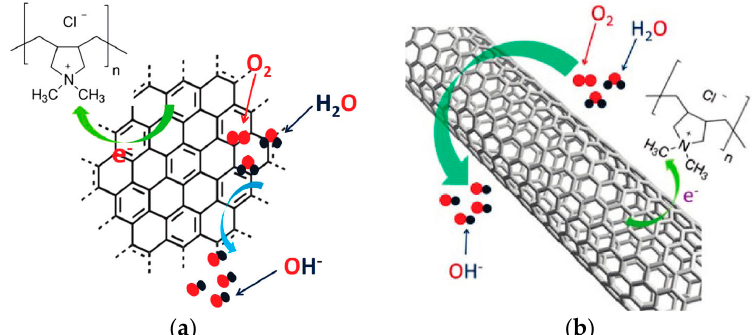
Figure 6. ( a ) Schematic illustration of the PDDA-induced electron-withdrawing interaction on graphene. (Reprinted with permission from Ref. [30], 2011 American Chemical Society) ( b ) Schematic illustration of charge transfer and ORR process on PDDA-CNT composite. Reprinted with permission from Ref. [31], 2011 American Chemical Society.